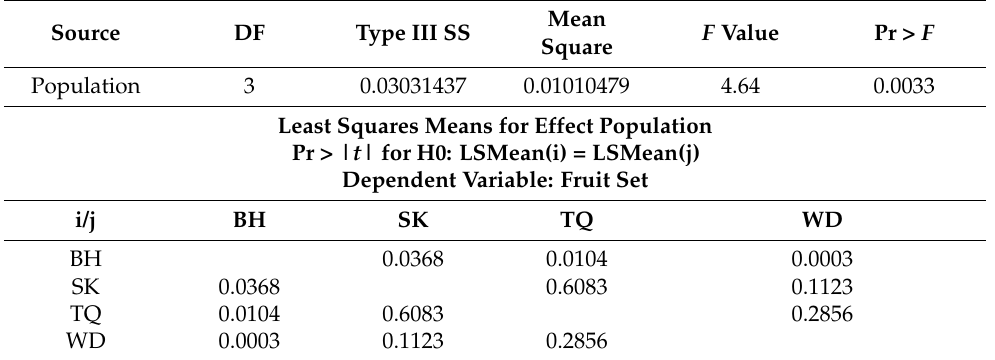
Table A7. 2019 Four Population Fruit